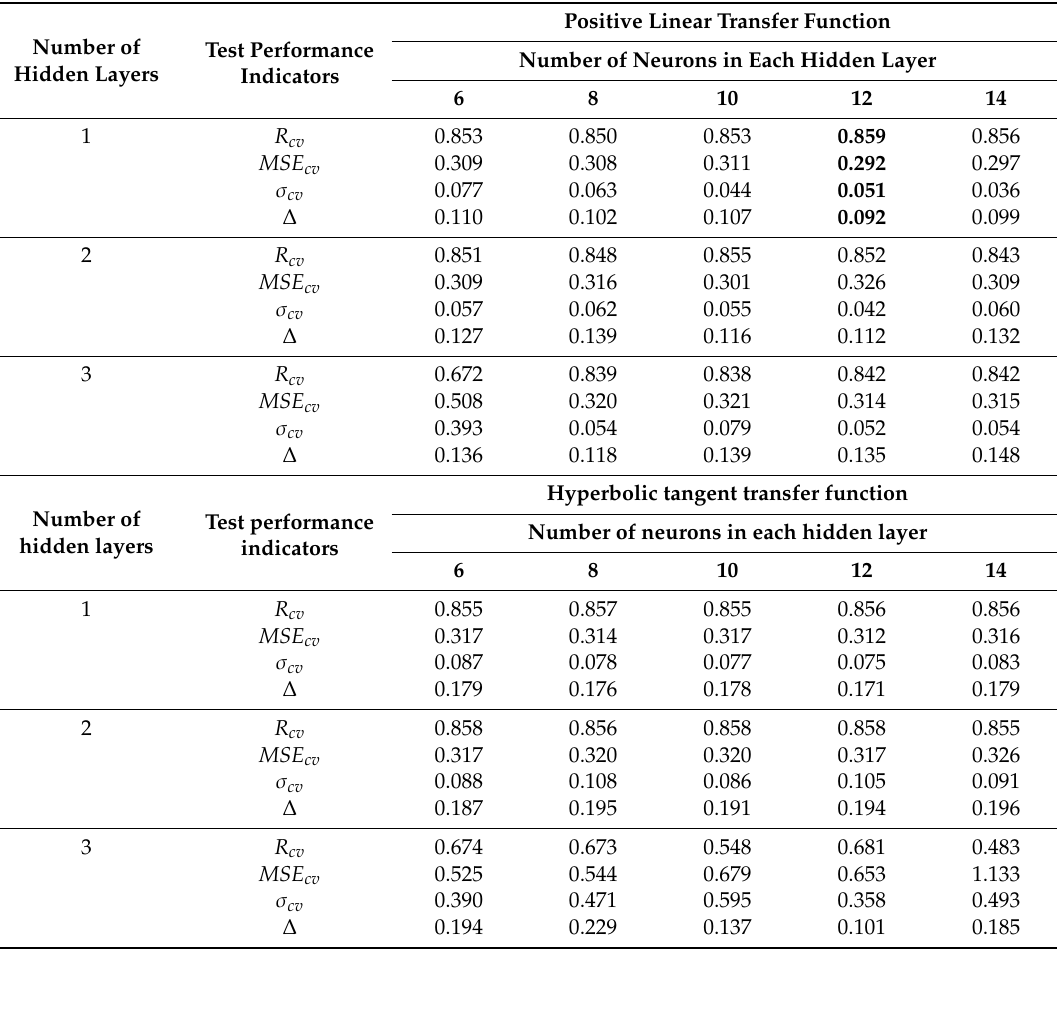
Table 6. Estimates of Marshall quotient models’ predictive performance by five-fold cross validation.